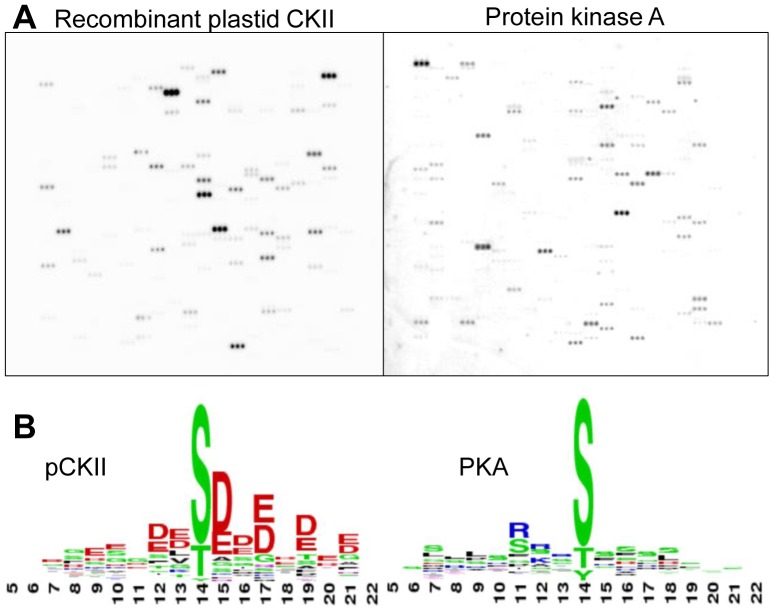
Microarray assay with recombinant pCKII and protein kinase A (PKA).(A) Shown is the autoradiography result obtained with one sub-array. (B) Phosphorylation motif used by the different kinases. Depicted are the weblogos (http://weblogo.berkeley.edu/) of signal peptides with centered phosphorylation sites in 3 bits latitude.